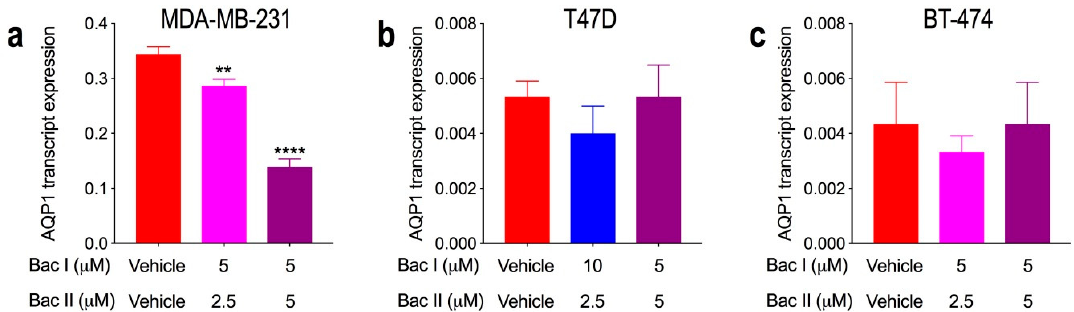
Figure 7. Relative aquaporin-1 (AQP1) transcript expression for breast cancer cell lines and the e ff ect of bac I and II combined. Cells were treated for 24 h with the vehicle or bac I and II. E ff ect of bac I and II on transcript expression of AQP1 relative to vehicle for ( a ) MDA-MB-231 (** p = 0.004, **** p < 0.0001), ( b ) T47D, and ( c ) BT-474. Data are the mean ± SD of three replicates, with AQP1 transcript expression normalised to the CCSER2 reference gene and expressed as 2 − ∆ Ct . P-values are relative to the vehicle and determined by one-way ANOVA with Bonferroni